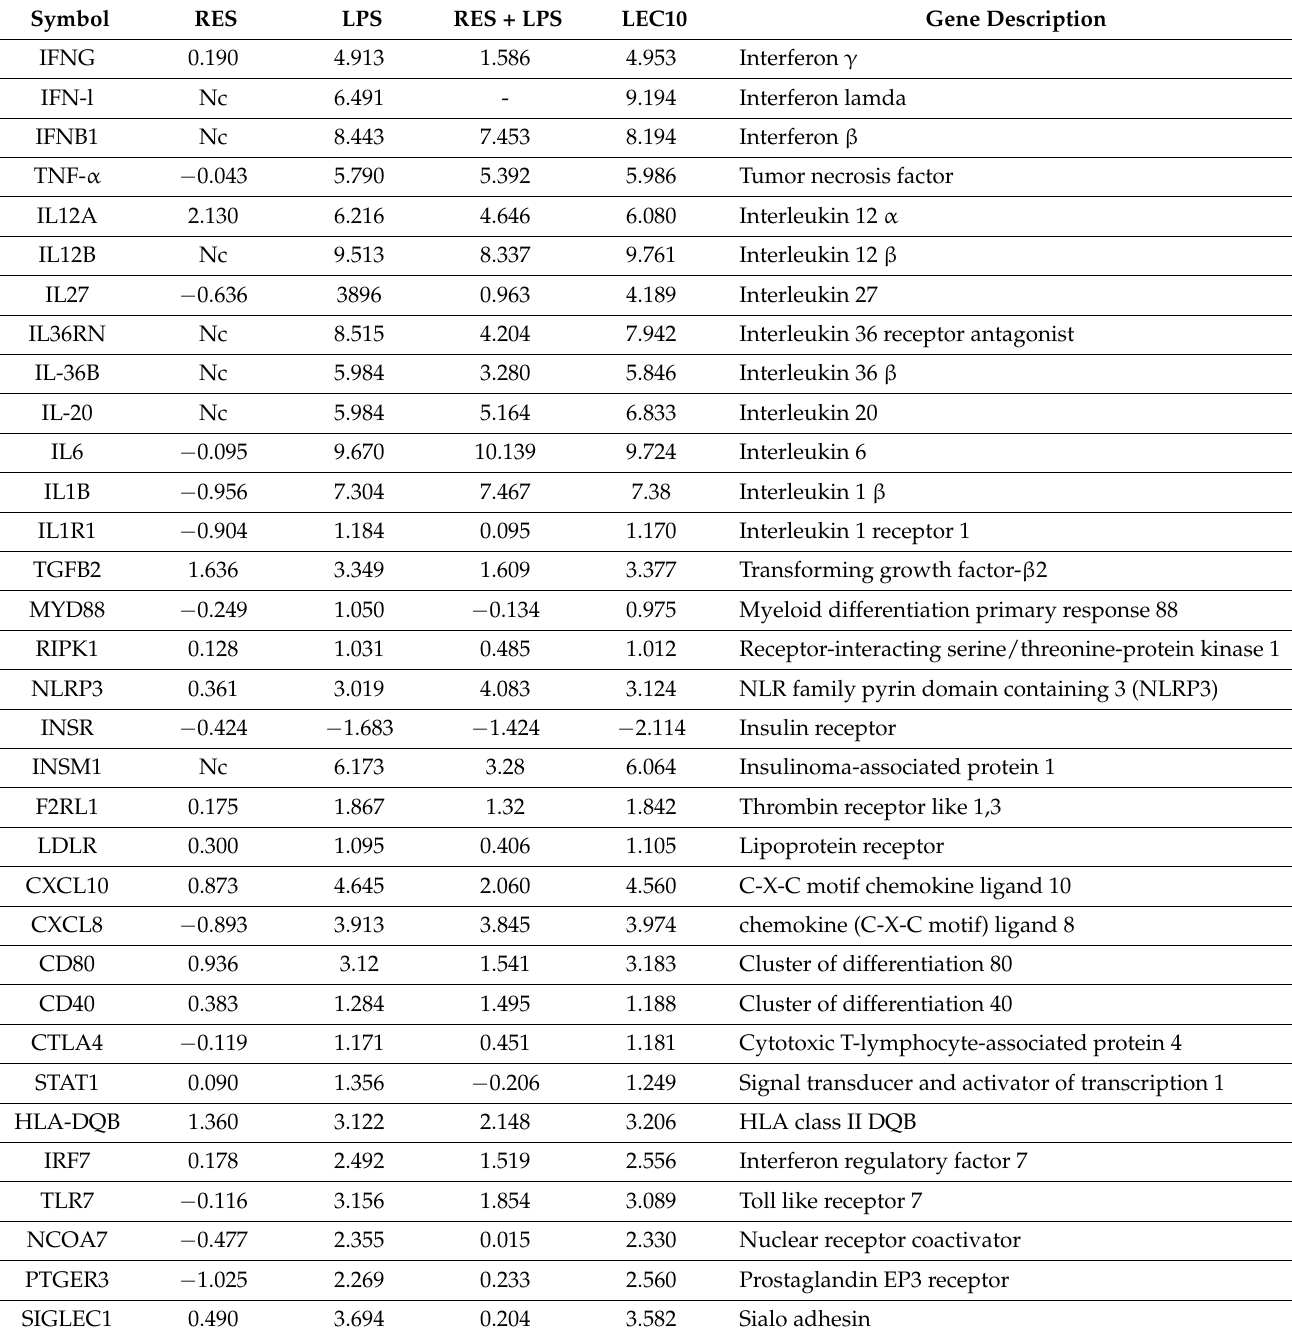
Table 4. Important genes in LPS induced pathways that are modulated by RES and